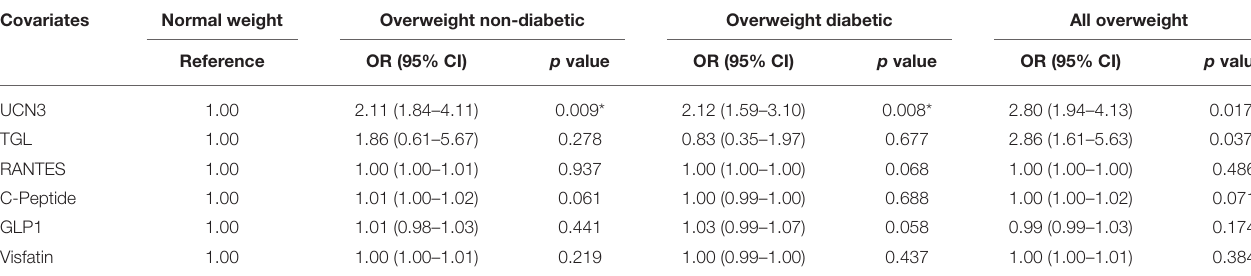
TABLE 4 | Odds Ratio analysis by binary logistic regression models compared to normal-weight subjects. Covariates Normal weight Overweight non-diabetic Overweight diabetic All overweight Reference OR (95% CI) p value OR (95% CI) p value OR (95%